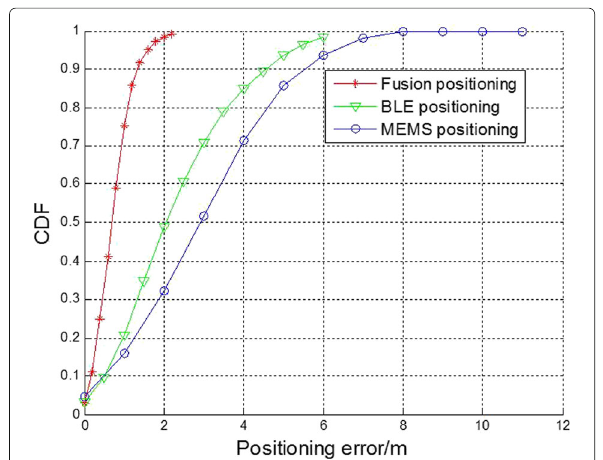
Fig. 32 CDF of positioning errors under squareshape of trajectory